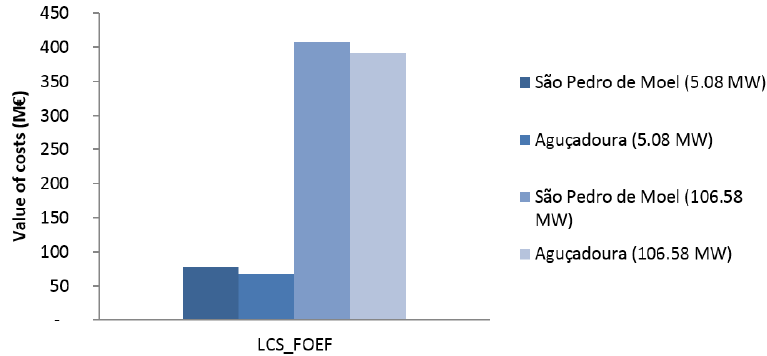
Figure 12. Life-cycle total cost of several wind farms in different locations.